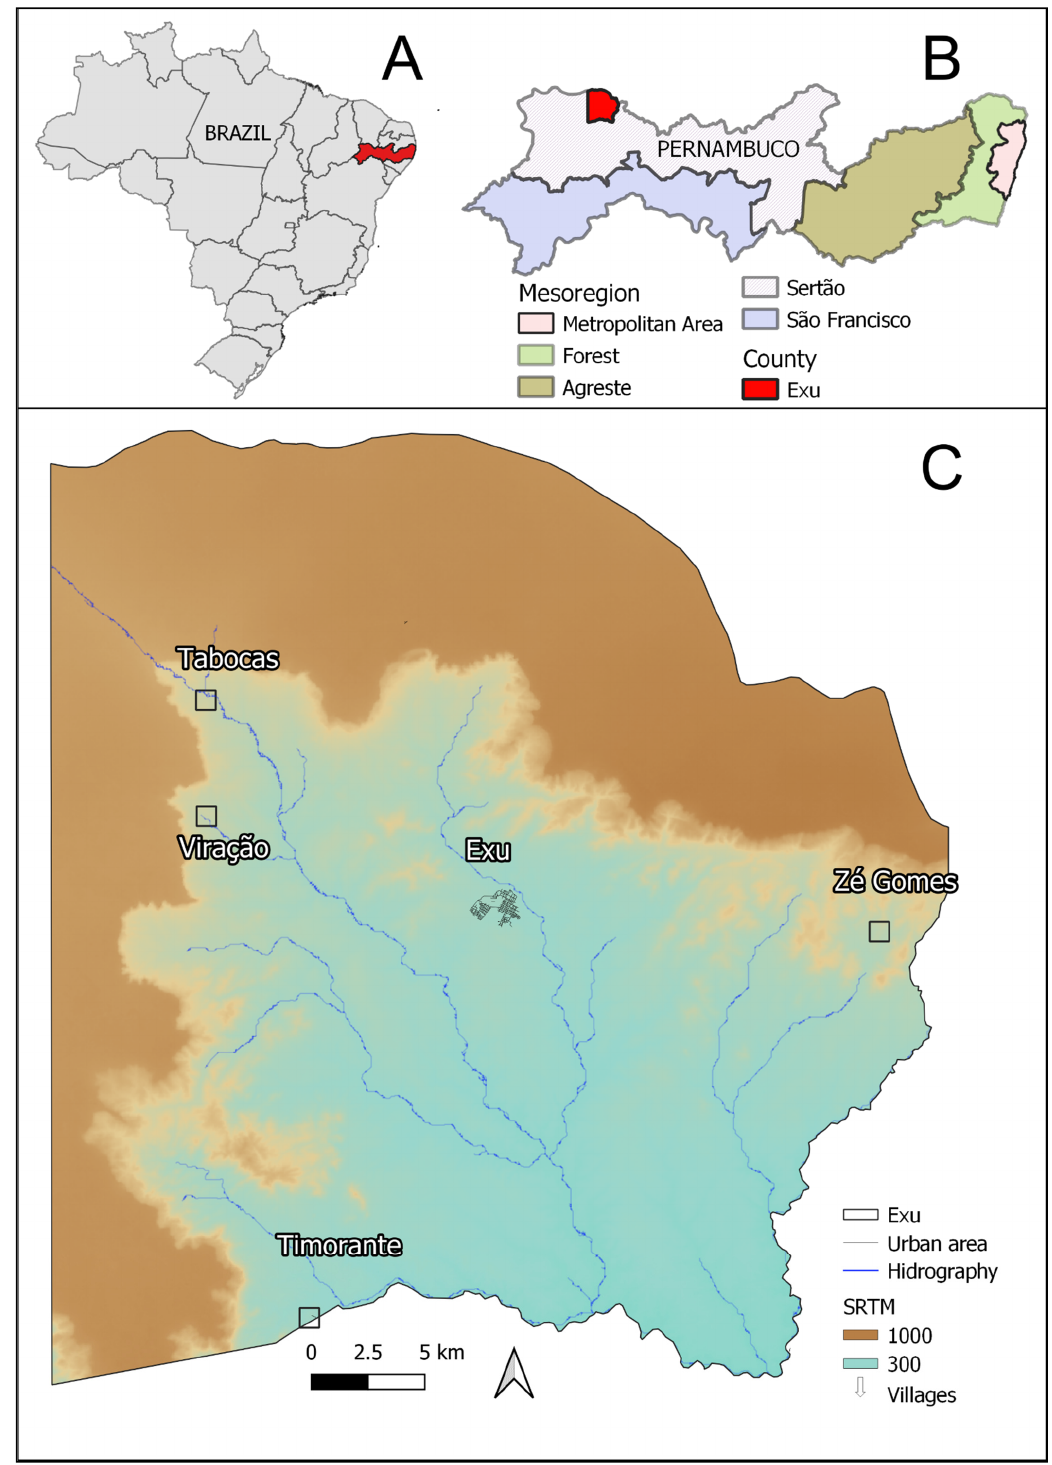
Figure 1. Identification of the study area: Exu, Pernambuco-Brazil. ( A ) Map of Brazil showing the state of Pernambuco highlighted in red. ( B ) Map of Pernambuco showing the mesoregions and the municipality of Exu highlighted in red. ( C ) Map of the municipality of Exu with hydrography and altitude (m), the urban area of Exu city (in the center) surrounded by other smaller rural settings the villages: Tabocas, Viraç ã o, Timorante and Z é Gomes. The shapefile of Exu was obtained from IBGE, the DEM from SRTM available online: http://www.dsr.inpe.br/topodata/ (accessed on 1 April 2021) and the hydrography from CPRM. These images are used for illustrative purposes